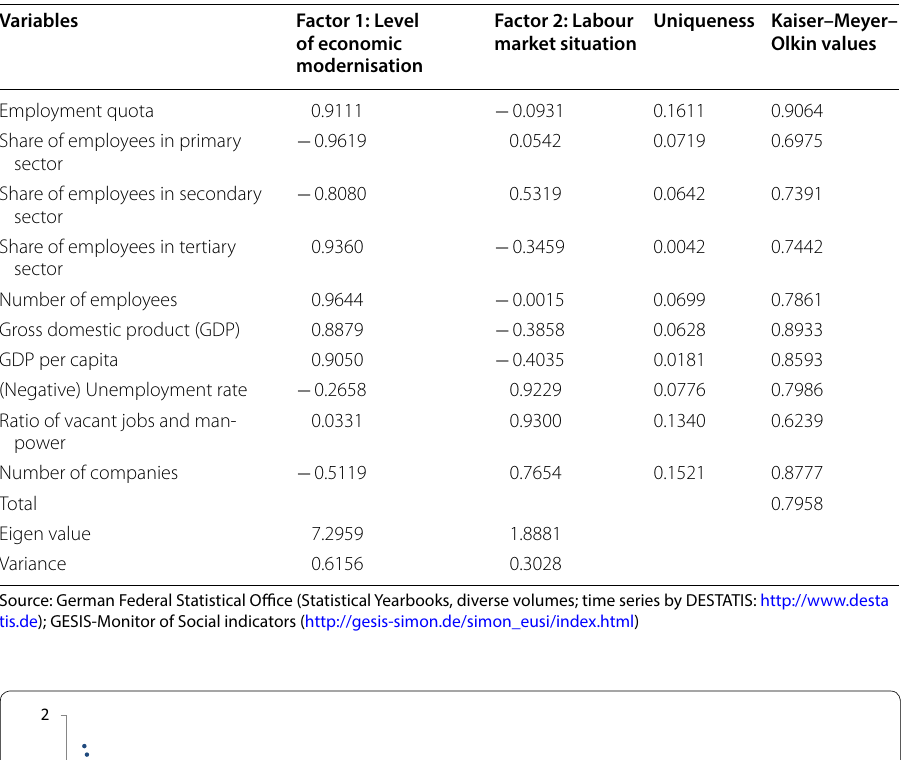
Table 1 Factor loadings (pattern matrix) and unique variances